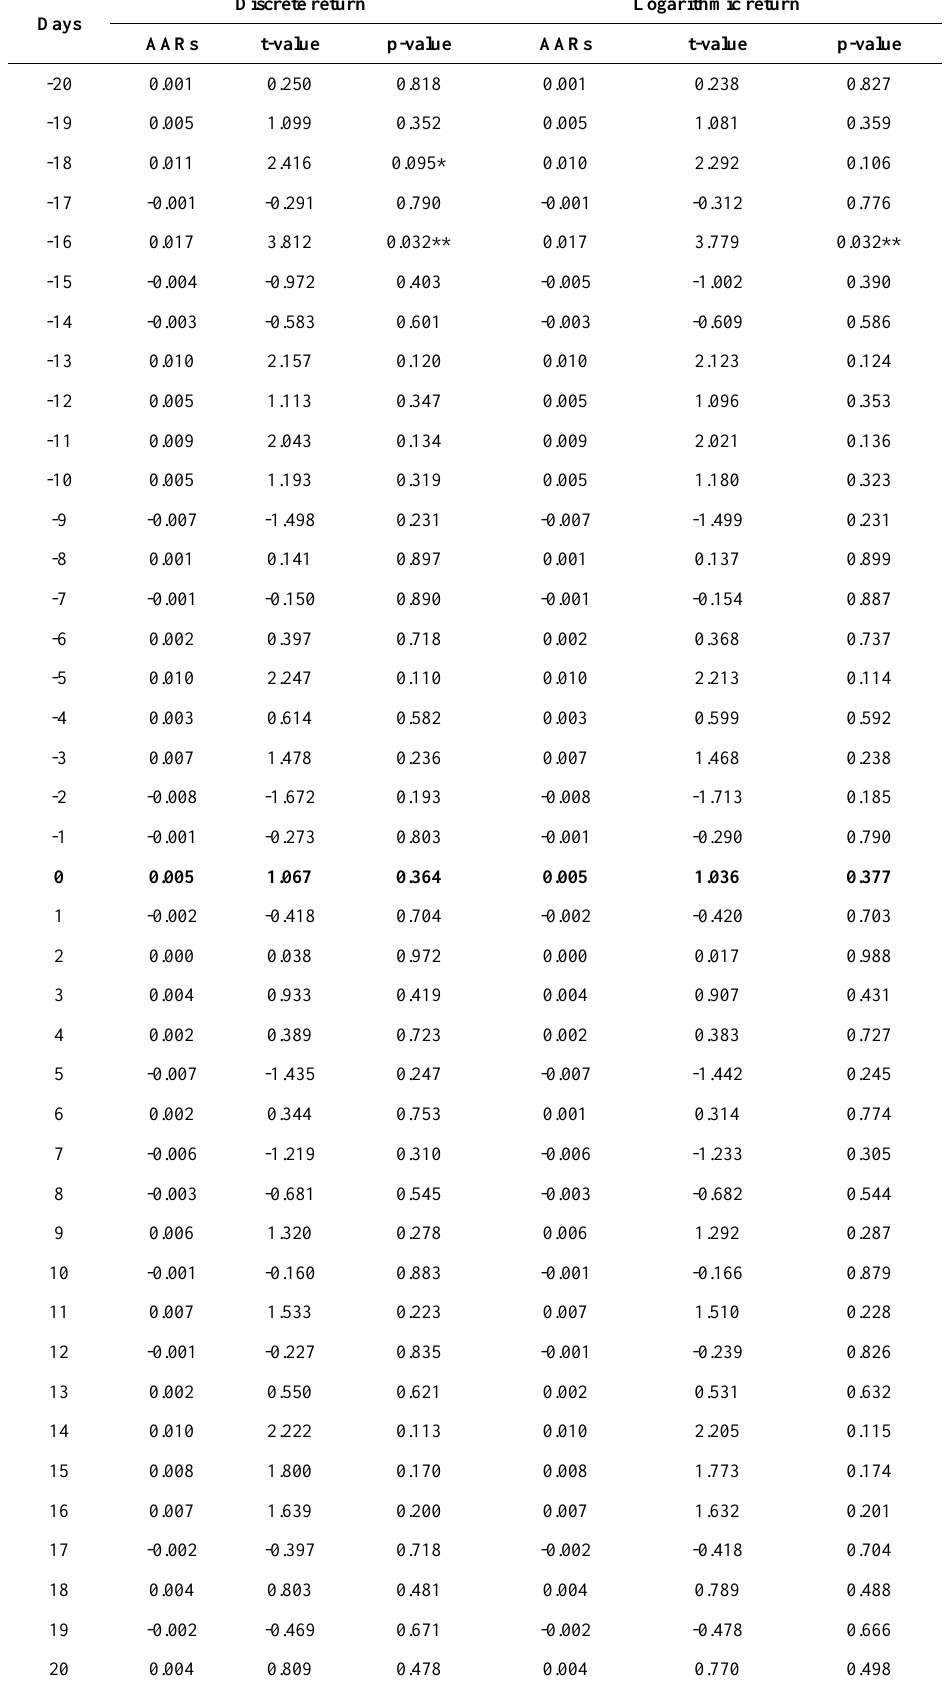
Table 4. Average abnormal returns (AARs) & t-values of stocks using both discrete and logarithmic returns for five